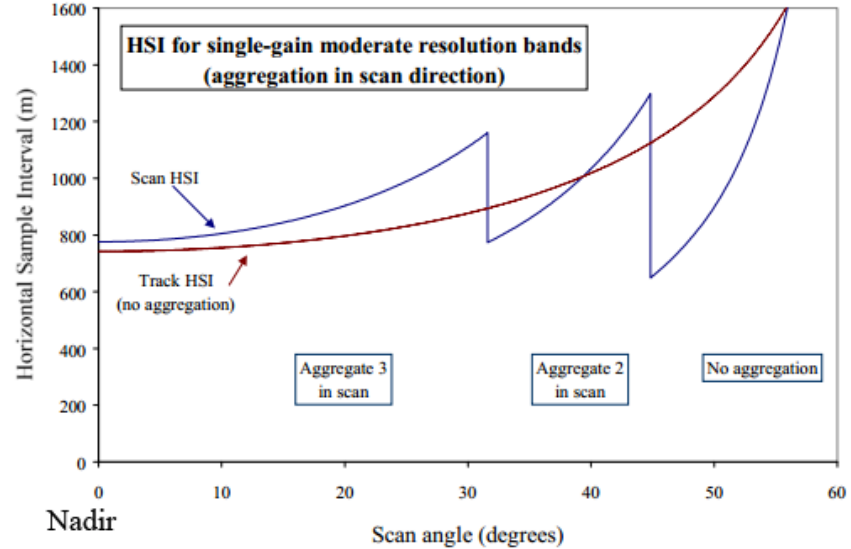
Figure 3. Horizontal sample interval chart shows how the growth of VIIRS M-band ground field of view from nadir to edge of scan is constrained by switching the number of pixels that are aggregated [12]. In aggregation zone 1, from nadir to 31.72 degrees, the signal from three pixels are averaged. In aggregation zone two, the signal from two pixels are averaged. In aggregation zone three, signal from a single pixel is